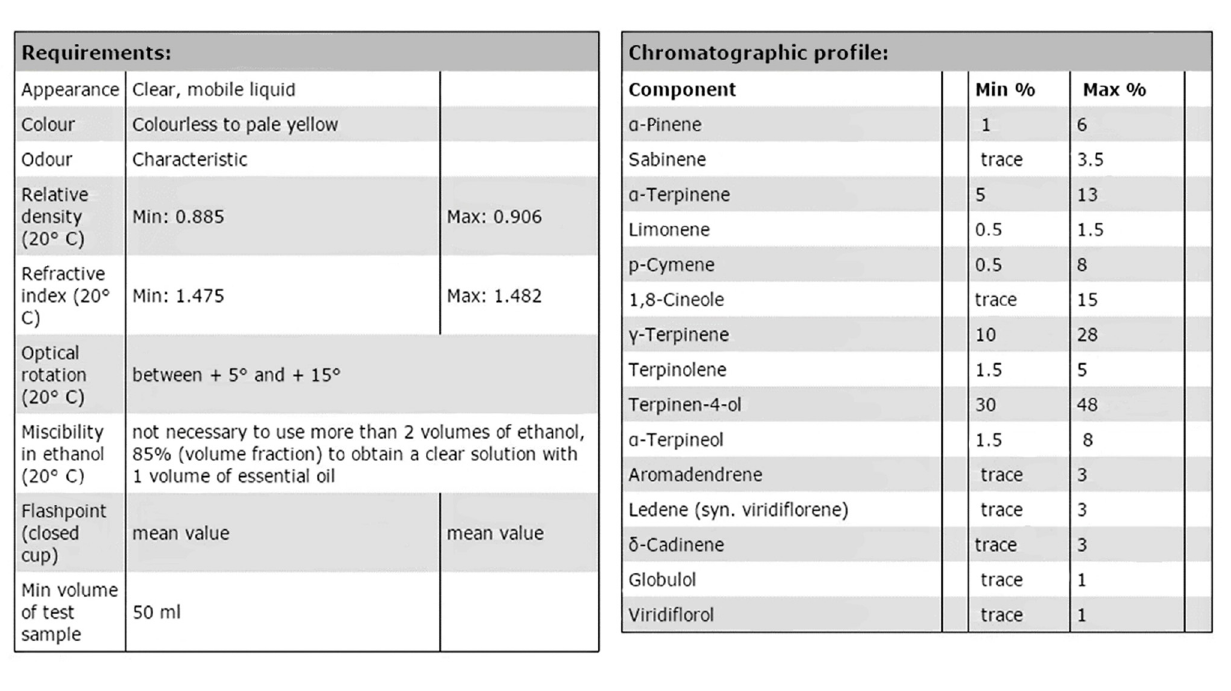
Figure 5. The Australian standard of chemical components in Tea Tree Oil (AS 2782: 2009), the terpinen-4-ol chemotype, Standards Australia